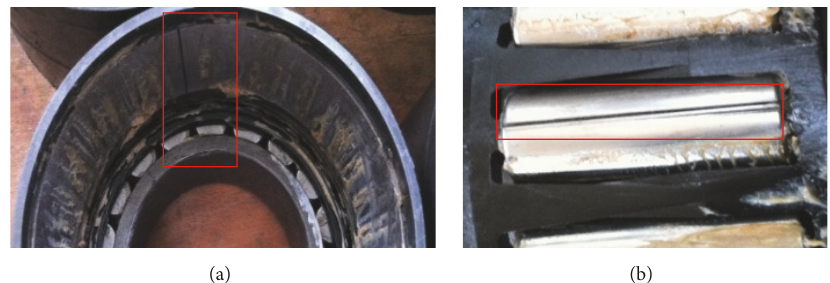
Figure 8: Photos of the artificial faults on outer race (a) and roller (b).